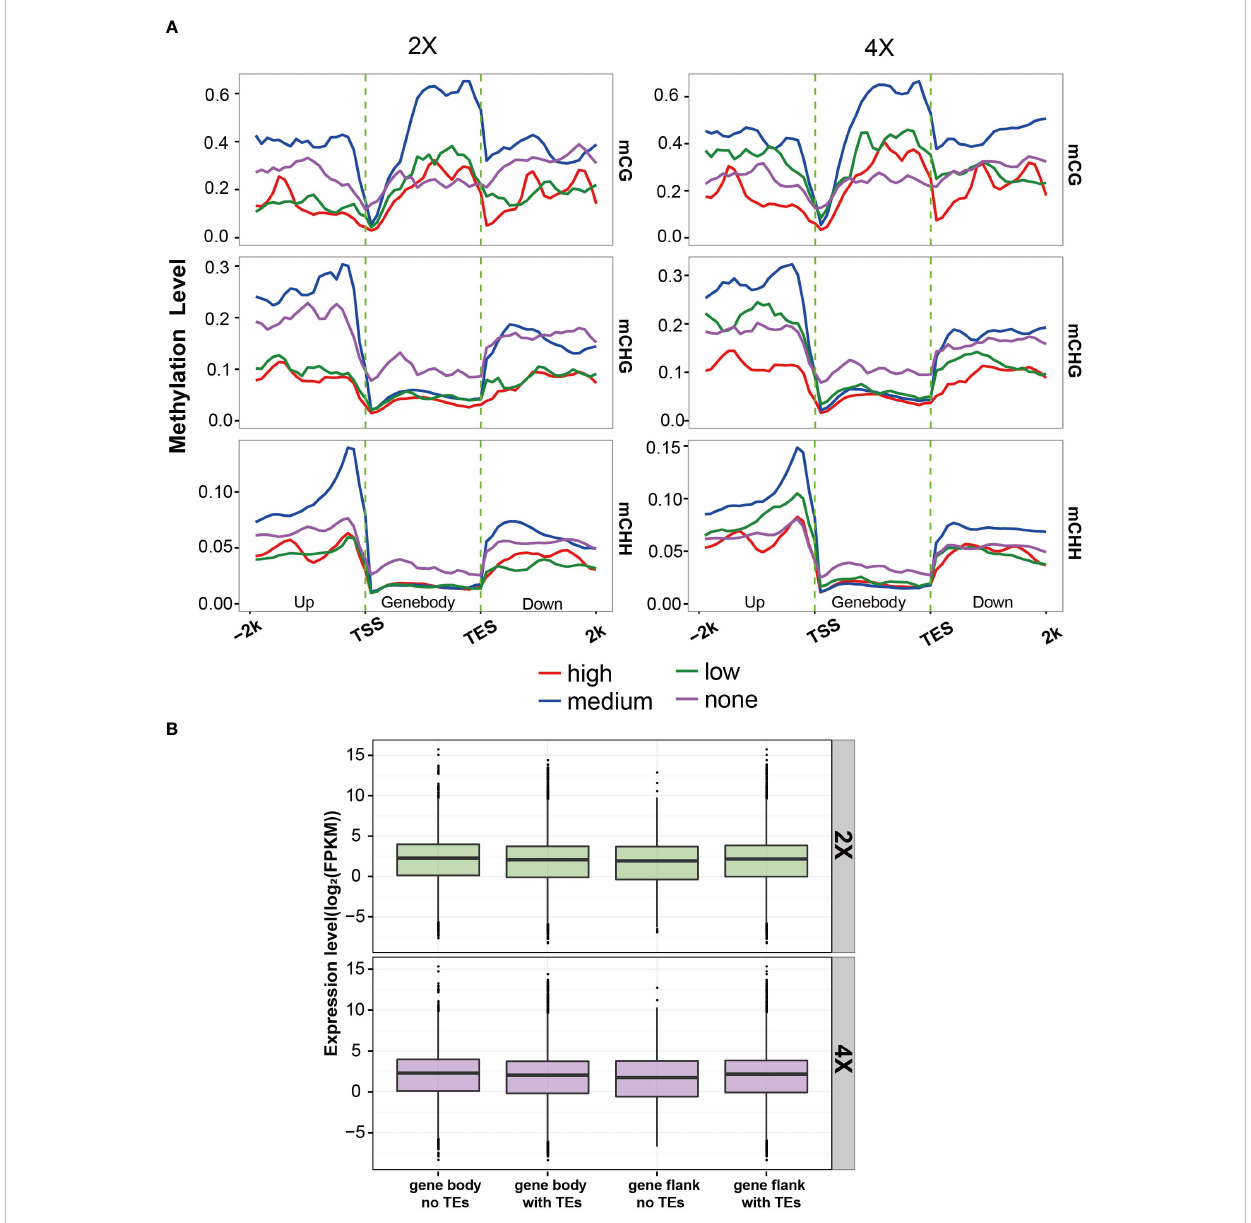
FIGURE 7 Correlation of gene expression with DNA methylation and TE insertion. (A) Association between DNA methylation level and gene expression in 2X and 4X water spinach. (B) The expression level of genes with or without TE